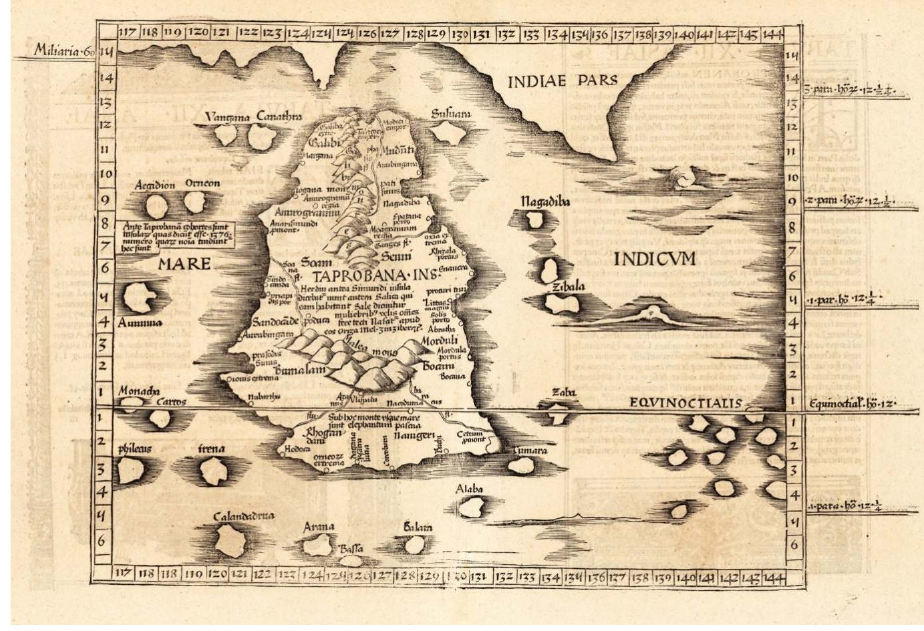
Libri octo, 1535.